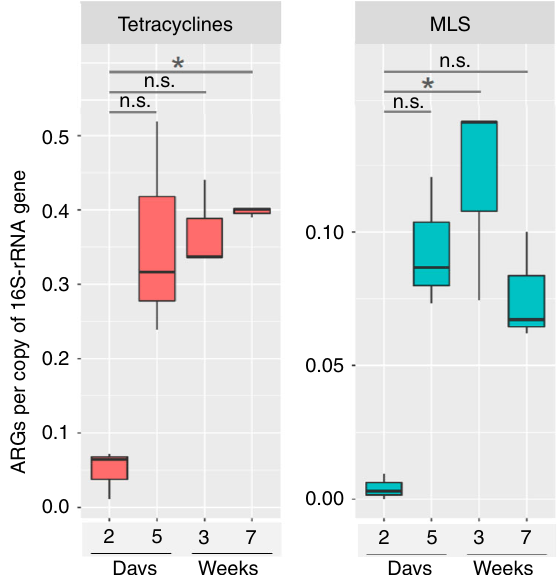
Fig. 4 The distribution of resistance to the class of MLS and tetracyclines. The analysis was based on the normalized ARGs data from the AMR ++ pipeline (see Methods). * P < 0.05, and n.s. indicates P > 0.05 by Friedman ’ s test followed by multiple pairwise comparisons using Nemenyi post-hoc test. Boxplots representing IQRs with median shown in